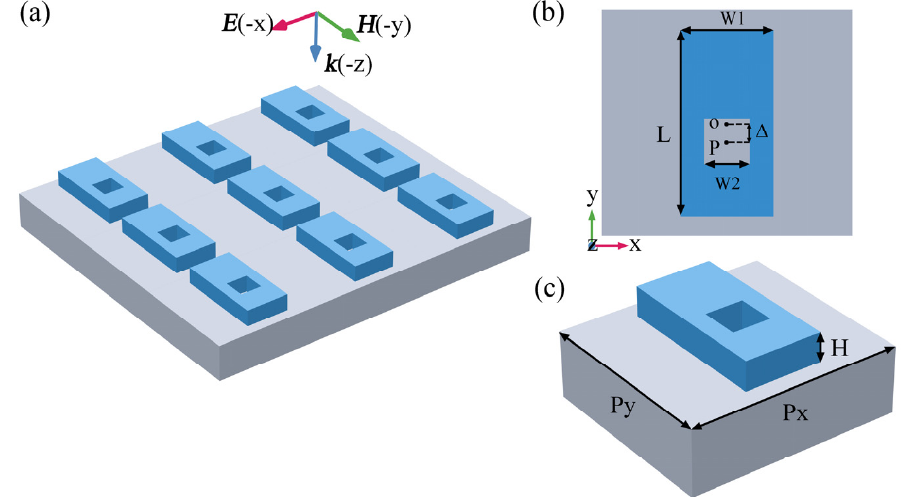
Figure 1. Schematic diagram of the structure of an all − dielectric metasurface. ( a ) Schematic diagram of the overall outline of the asymmetric nanohole metasurface; ( b ) cell structure diagram of the metasurface; ( c ) top view of the cell structure.